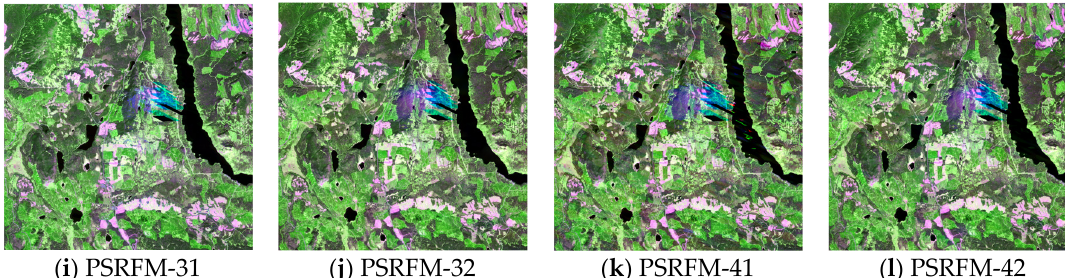
Figure 9. Visual comparison of the observed Sentinel-2 MSI image ( a ) and ( b ) (same as ( a ) but marked with the unavailable pixel values of the MODIS image on the prediction date for purpose of comparison) on August 15, 2018 and the predicted images ( e – l ) by PSRFM- ij ( i = 1, 2, 3, 4, j = 1, 2), ( c ) STARFM and ( d ) ESTARFM using two pairs of Sentinel-2 MSI and MODIS BRDF adjusted images acquired on July 31, 2018 and September 22, 2018 respectively. All images are in SWIR1-NIR-SWIR2 (R-G-B) false color composites.